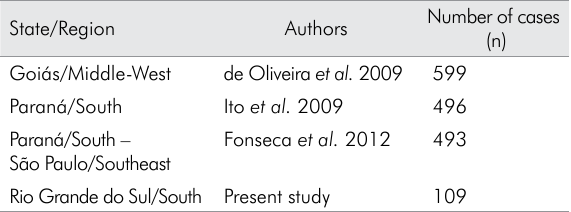
Table 5. Reports of salivary gland tumors in different states and regions in